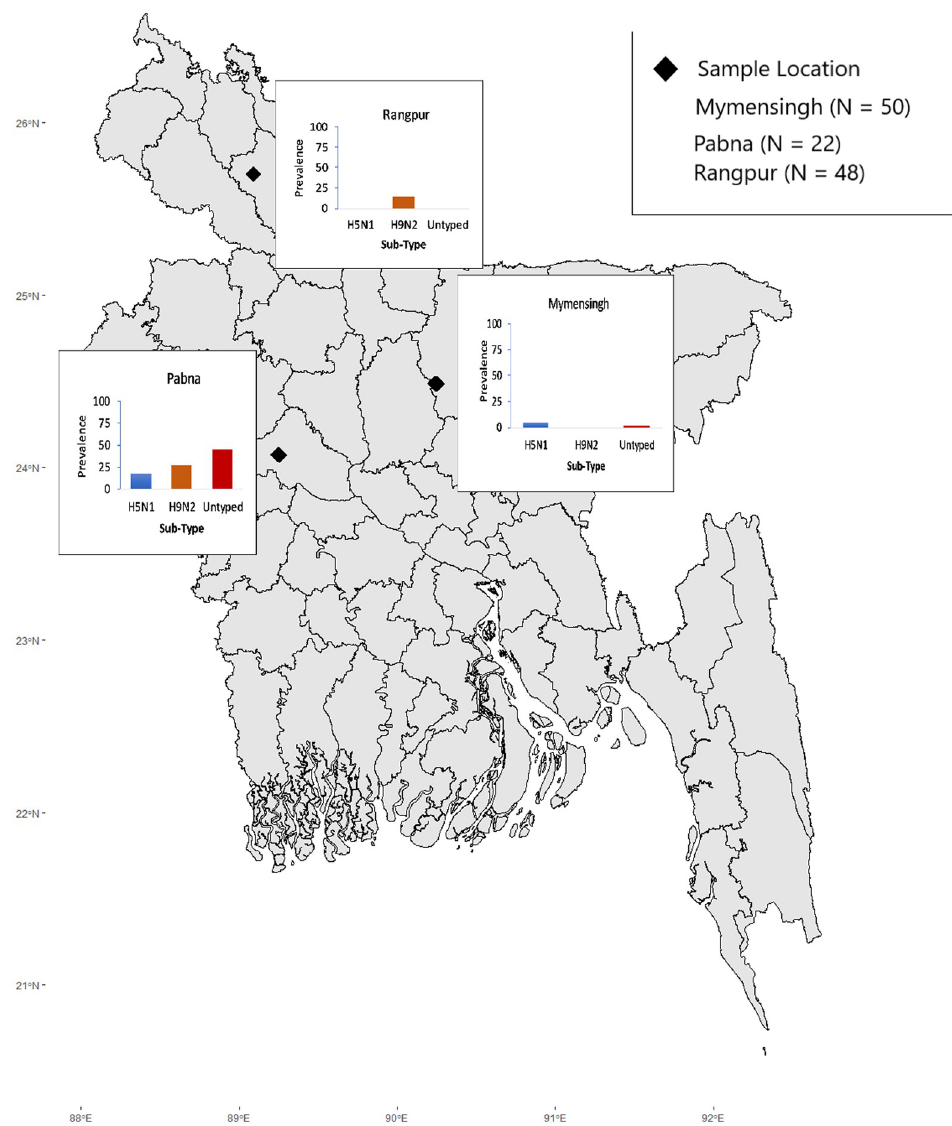
Fig 1. Location of sample and prevalence of H5N1, H9N2, and Influenza A/Untyped.